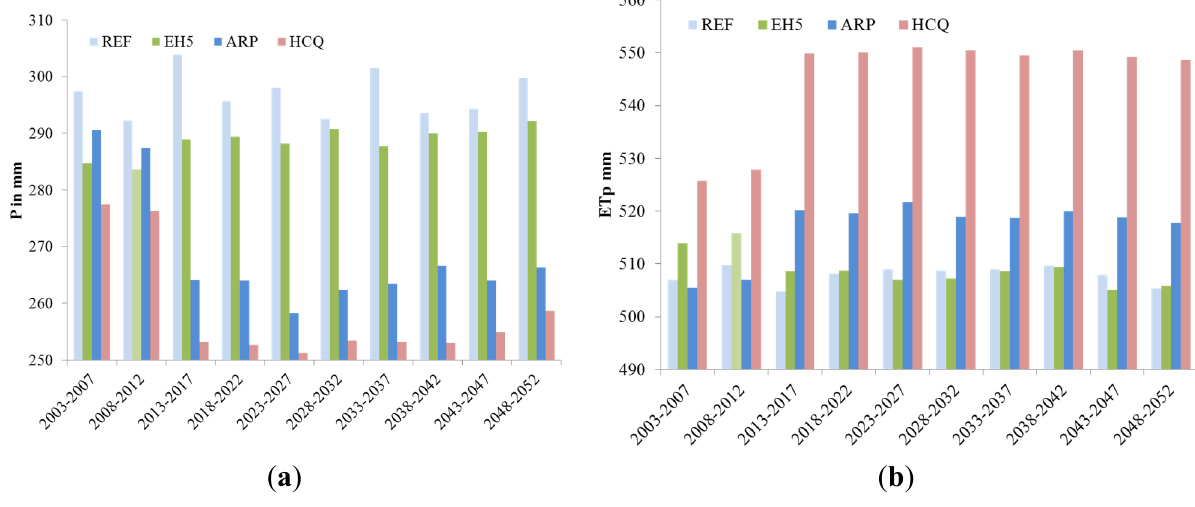
Figure 5. ( a ) Average five-year precipitation and ( b ) potential evapotranspiration during the vegetation period (May to September) of the climate projections used in